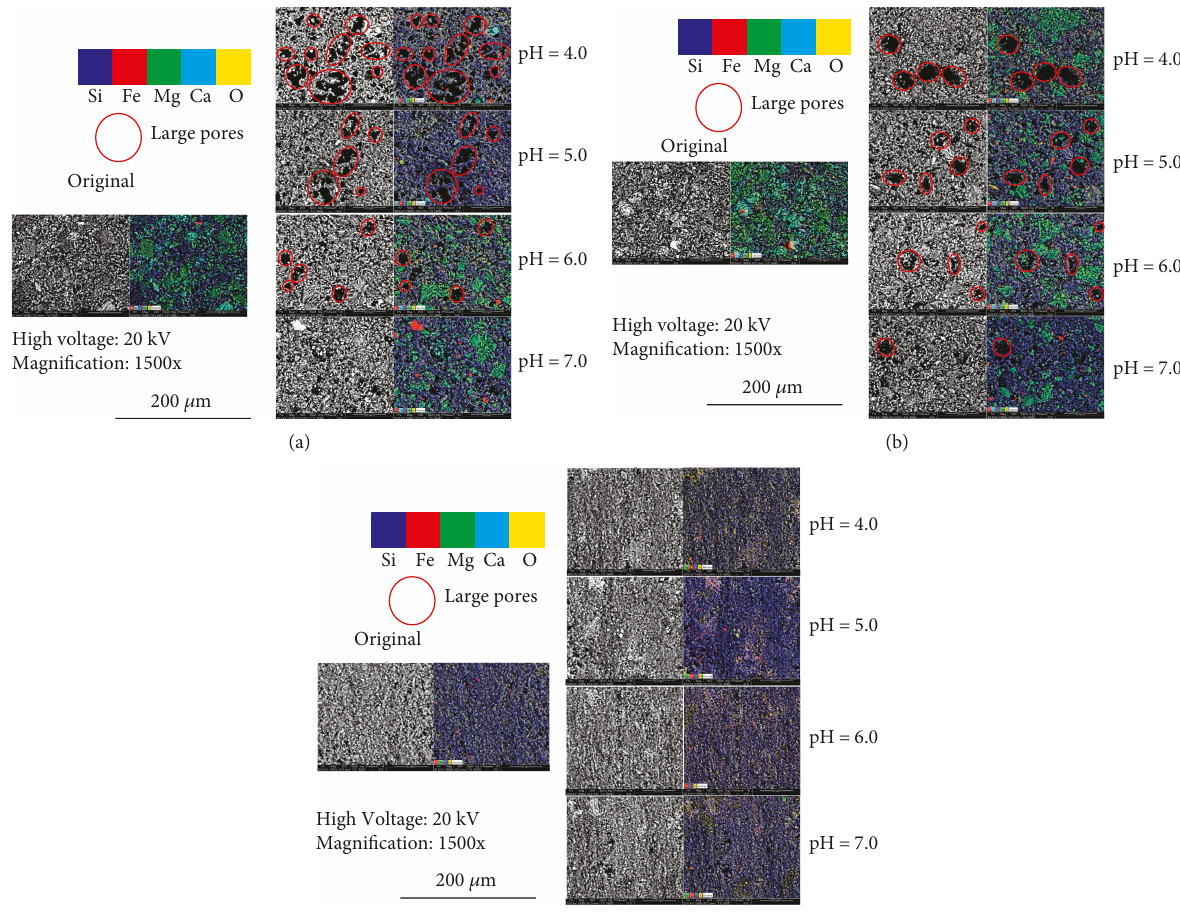
Figure 10: SEM images and corresponding EDS images of the fracture surface (window 1) after core fl ooding tests under various fl uid pH when con fi ning stress is 10MPa. (a) Longmaxi shale, (b) Green River shale, and (c) Marcellus